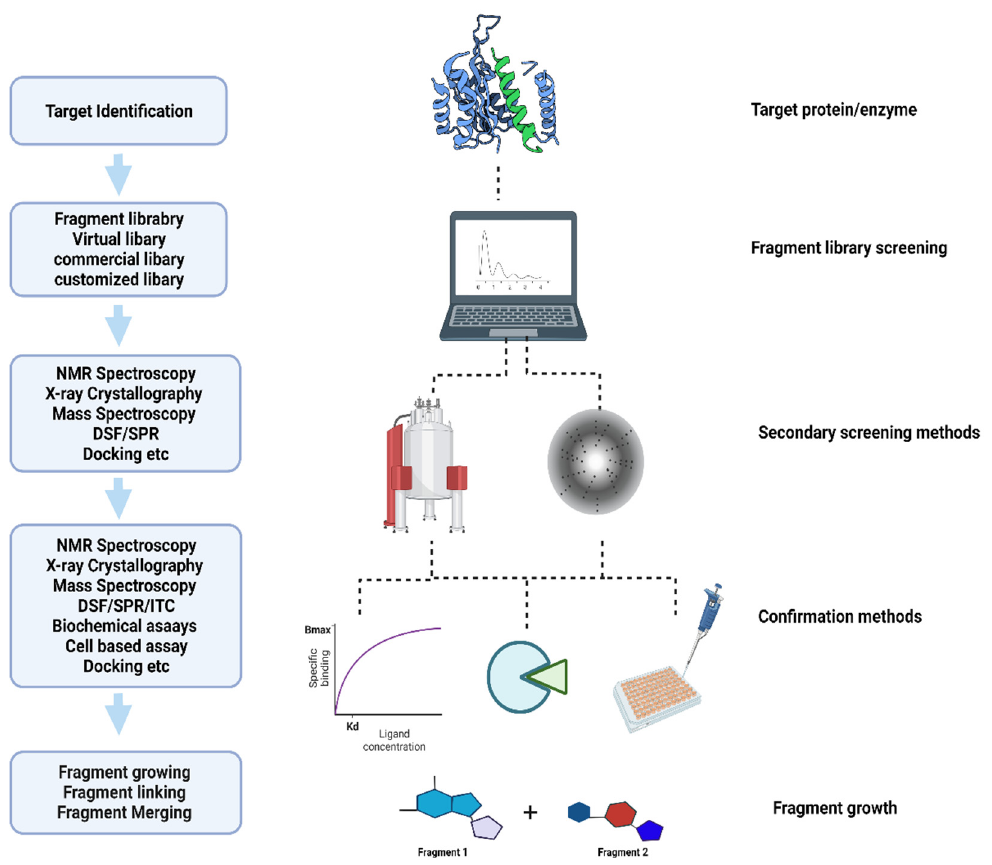
Figure 1. Flow chart of fragment-based drug discovery.